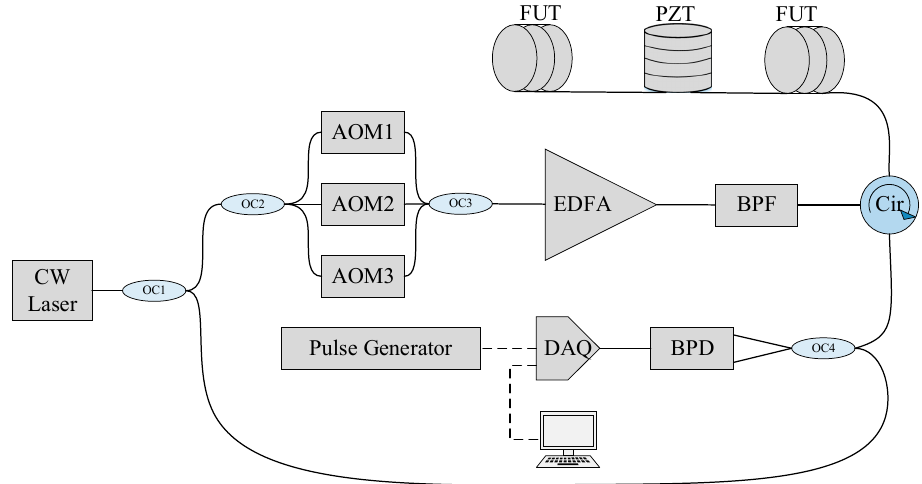
Figure 5. The scheme of proposed Φ -OTDR sensing system I. CW Laser: continuous wave laser; AOM: acoustic-optical modulator, EDFA: erbium doped fiber amplifier; BPF: band-pass filter; Cir: circulator; FUT: fiber under test; PZT: piezo-electric transducer; BPD: balanced photo-detector; DAQ: data acquisition card.